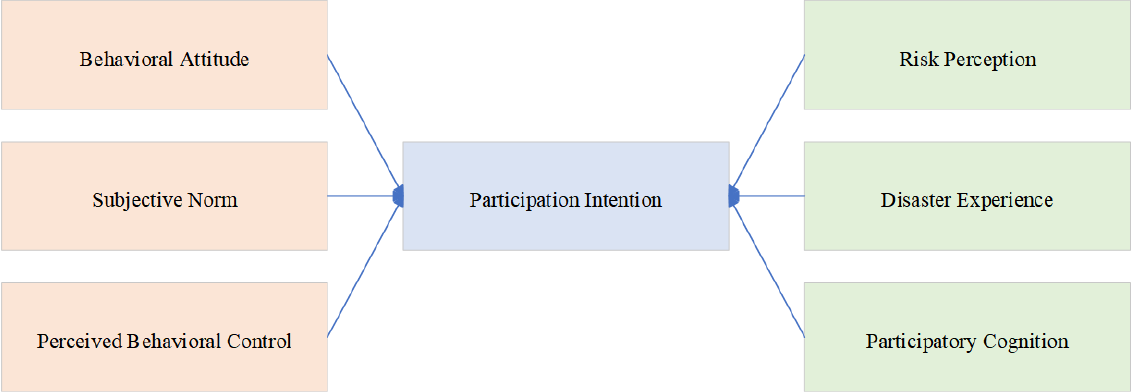
Figure 1. Conceptual model: expanding the TPB